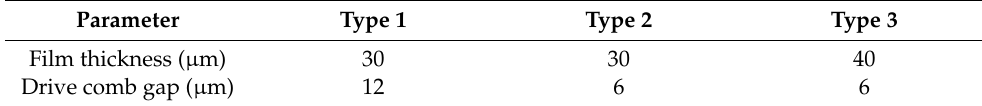
Table 5. Simulation modeling parameter table of MEMS